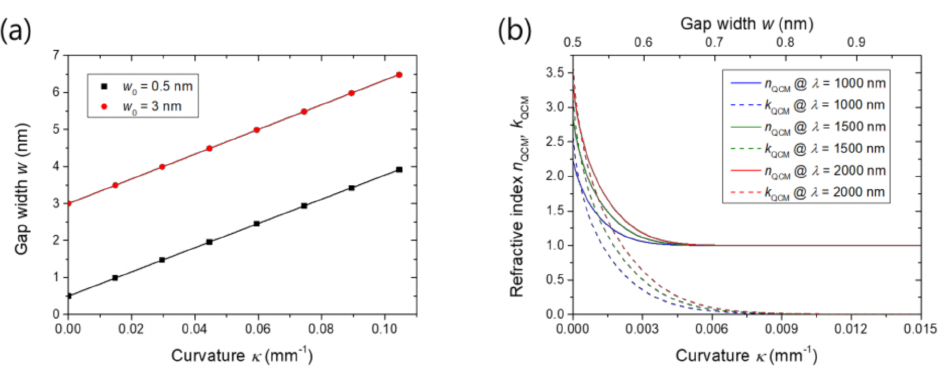
Figure 7. Effect of the initial gap width and quantum tunneling: ( a ) Gap width versus substrate curvature for initial gap widths of 0.5 and 3 nm. Solid lines are linear fits; ( b ) Real and imaginary parts of the refractive indexes n QCM , k QCM of air in the gap calculated from the quantum corrected model for wavelengths of 1000, 1500 and 2000 nm. The initial gap width is 0.5 nm. The curvature range of 0 to 0.015 mm − 1 on the bottom axis is translated into the gap width range of 0.5 to 0.99 nm on the top